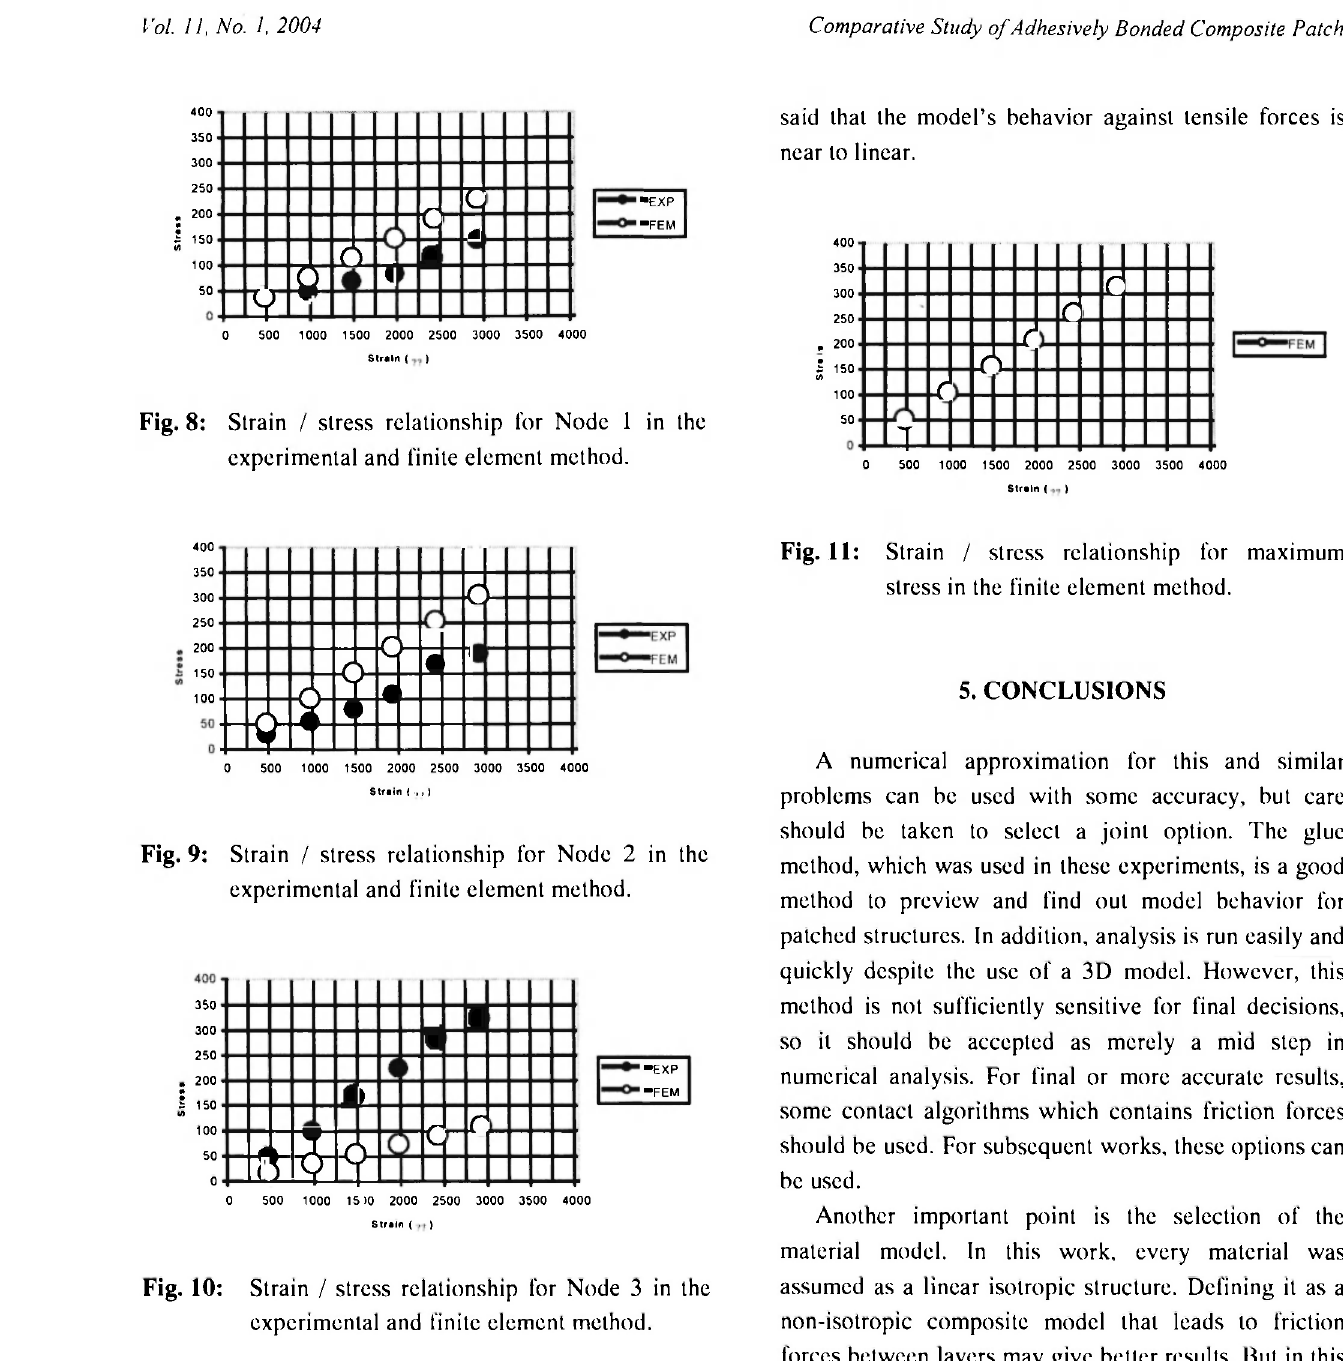
Fig. 10: Strain / stress relationship for Node 3 in the experimental and finite element method.